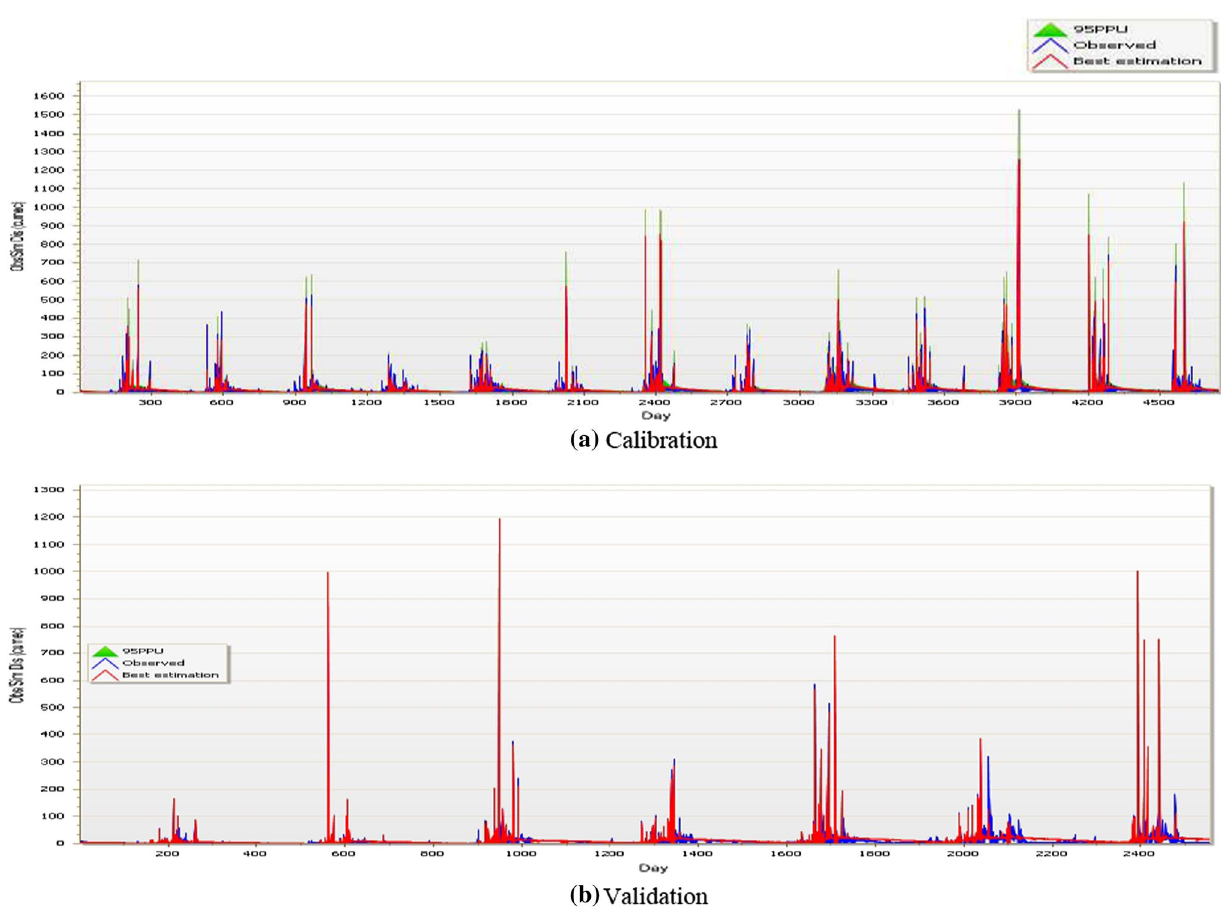
Fig. 7 Observed and simulated from SWAT model